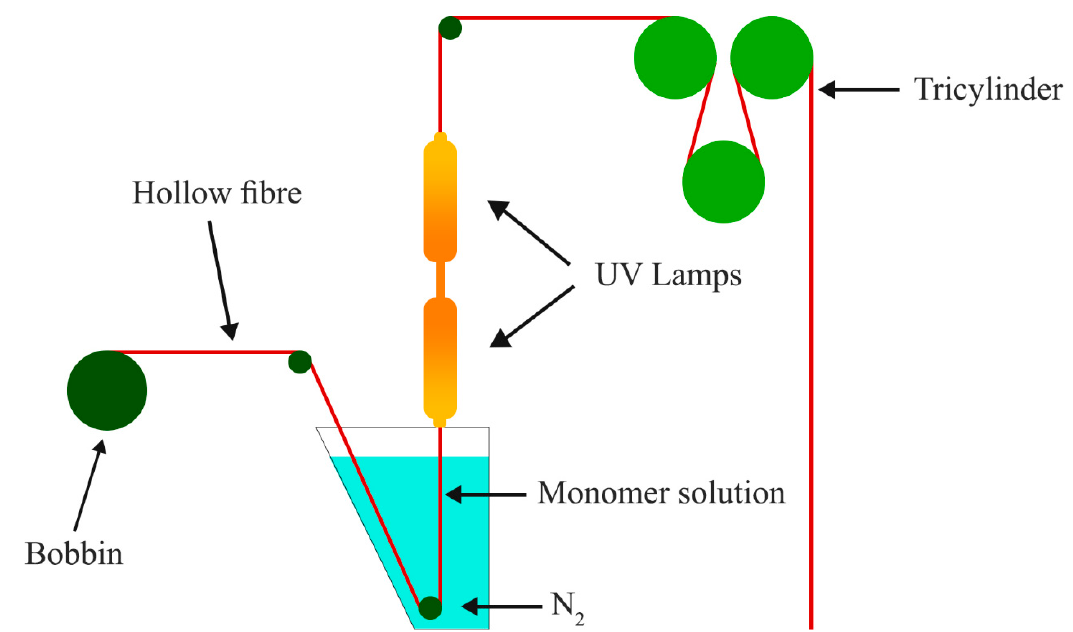
Figure 3. UV-photo-grafting setup for hollow-fiber membrane fabrication.